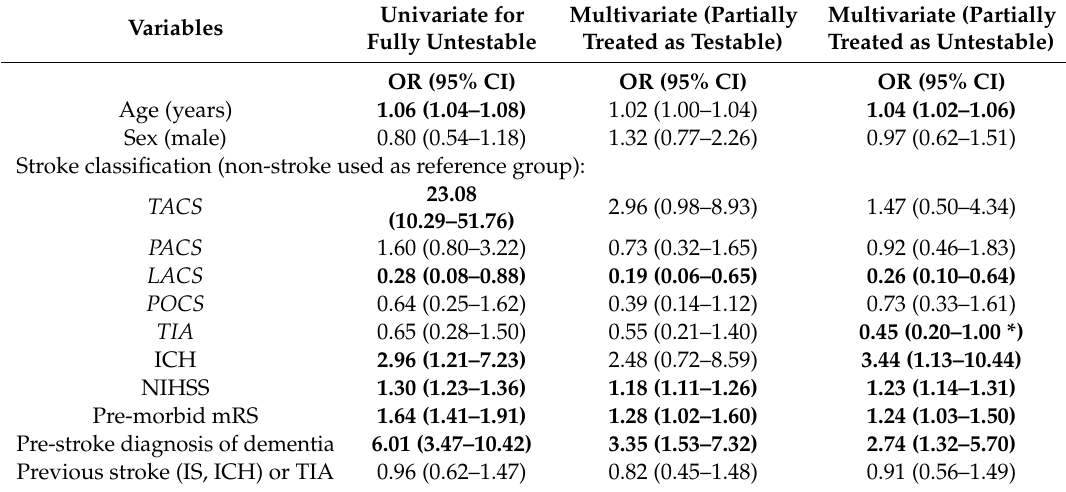
Figure 1. Reasons for fully / partially untestable. Table 4. Feasibility